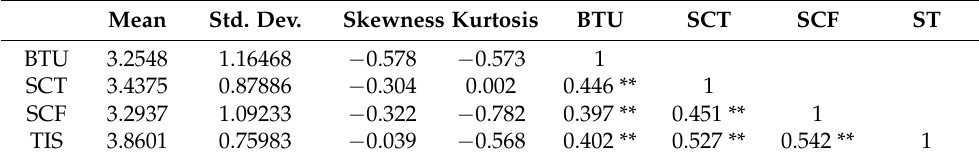
Table 5. Correlation